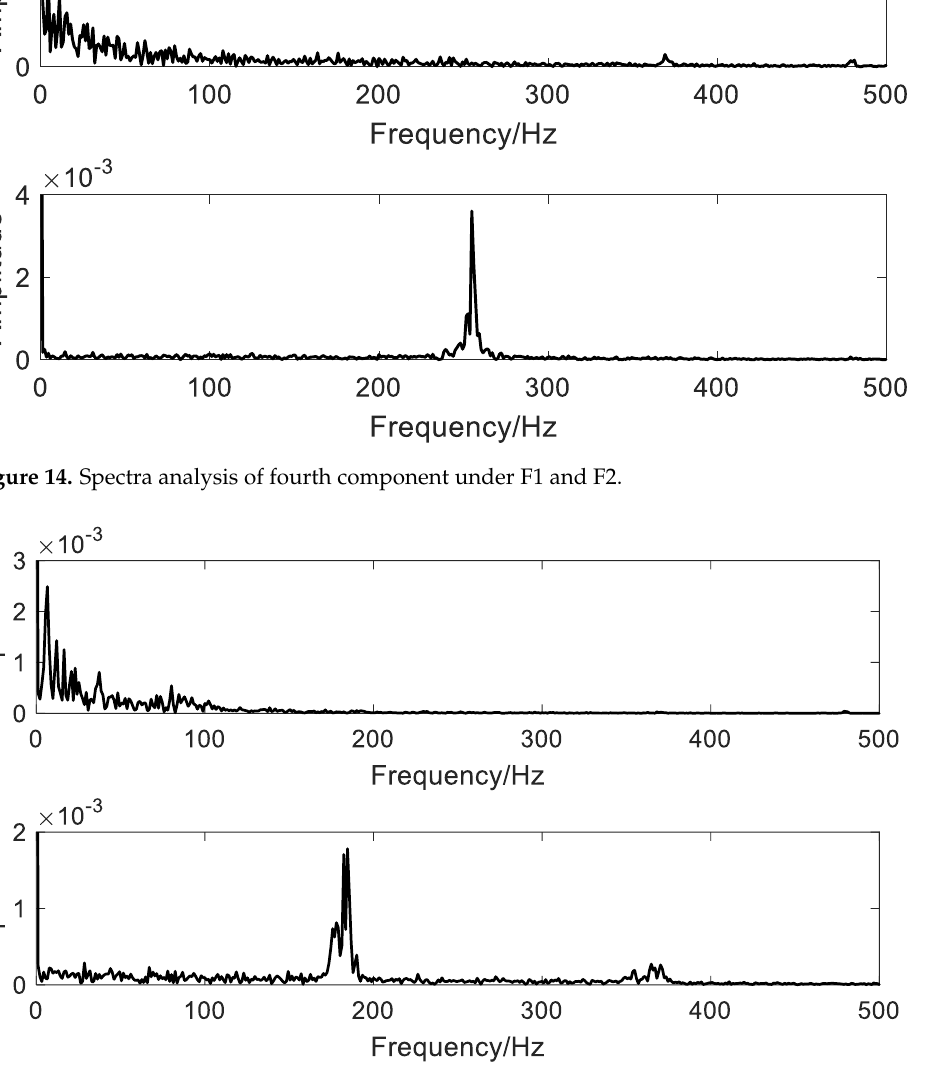
Figure 16. Spectra analysis of third component under F1 and F4. The time – frequency features extracted from the multi-source signals by PARAFAC decomposition are inputted to the BP model as features. The classification accuracy of the model was calculated. The output of the BP model and the corresponding state of the centrifugal pump are shown in Table 2. Table 2. Expected output of neural network corresponding to each state of centrifugal pump. Output Label